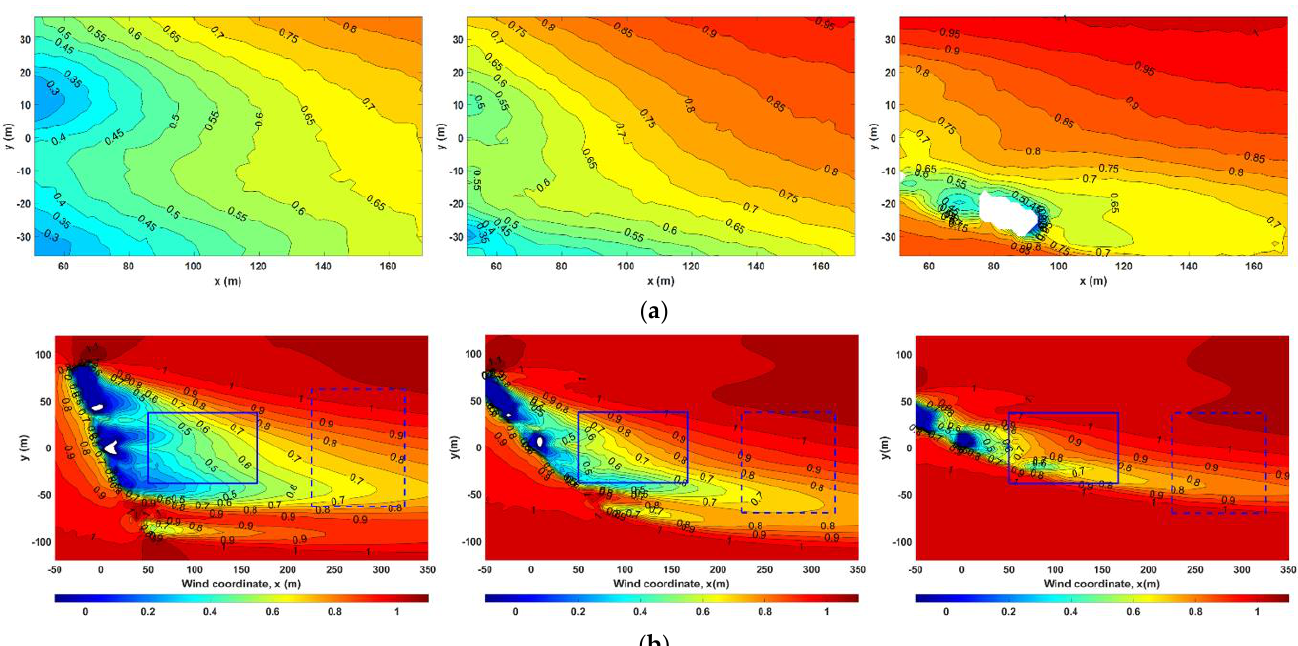
Figure 3. Contours of U / U ref at the height of 10 m ( a ) PIV measurements in the near-wake (ROI-1) region; ( b ) RANS-based CFD simulation results. (Left column: 22.5 ◦ ; middle column: 45 ◦ ; right column: 67.5 ◦ . The solid line marks the ROI-1 region while the dashed line defines the ROI-2 region).